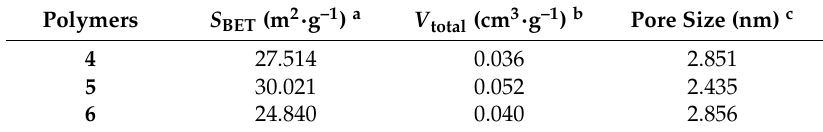
Table 5. Surface area and porosity parameters of 4 – 6 obtained by the N 2 adsorption.